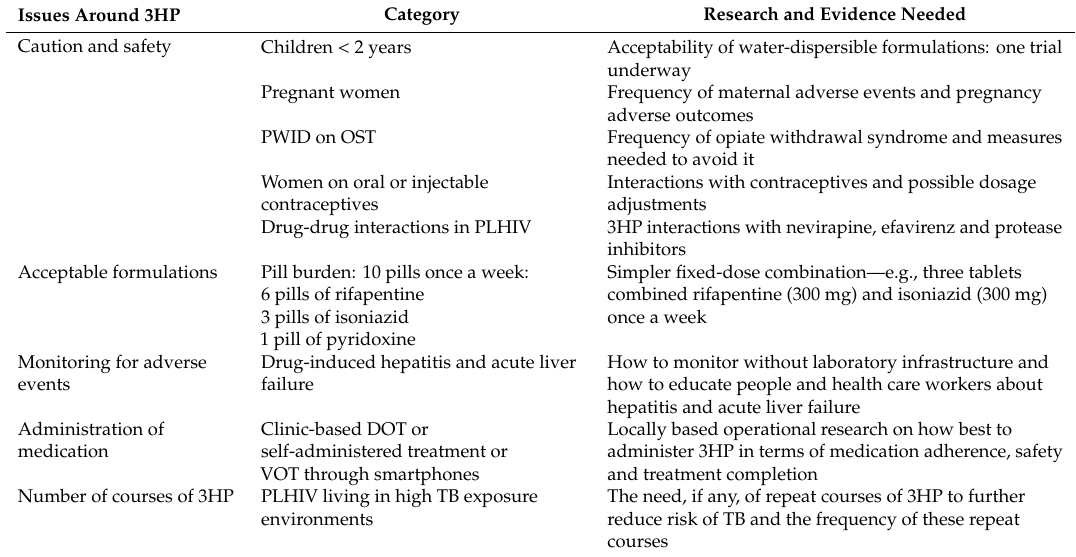
Table 6. Research and innovation on the 3-month weekly rifapentine and isoniazid (3HP) treatment regimen. Issues Around 3HP Category Research and Evidence